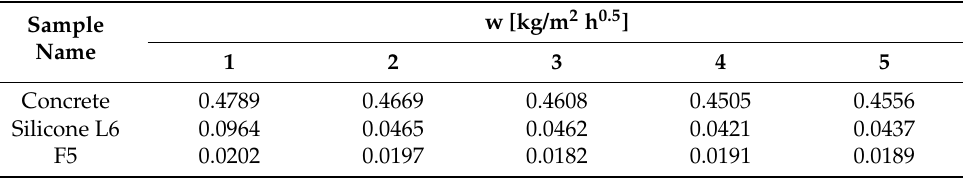
Table 6. Relative water permeability (w) after 24 h of the immersion of concrete samples without and with silane